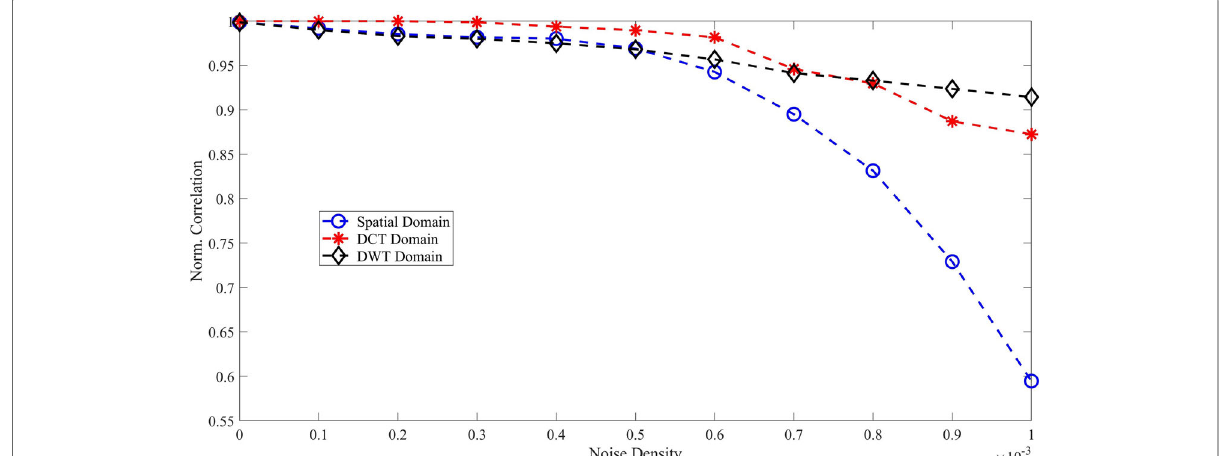
Fig. 12 Correlation value versus noise density in the three investigated domains (averaged over 50